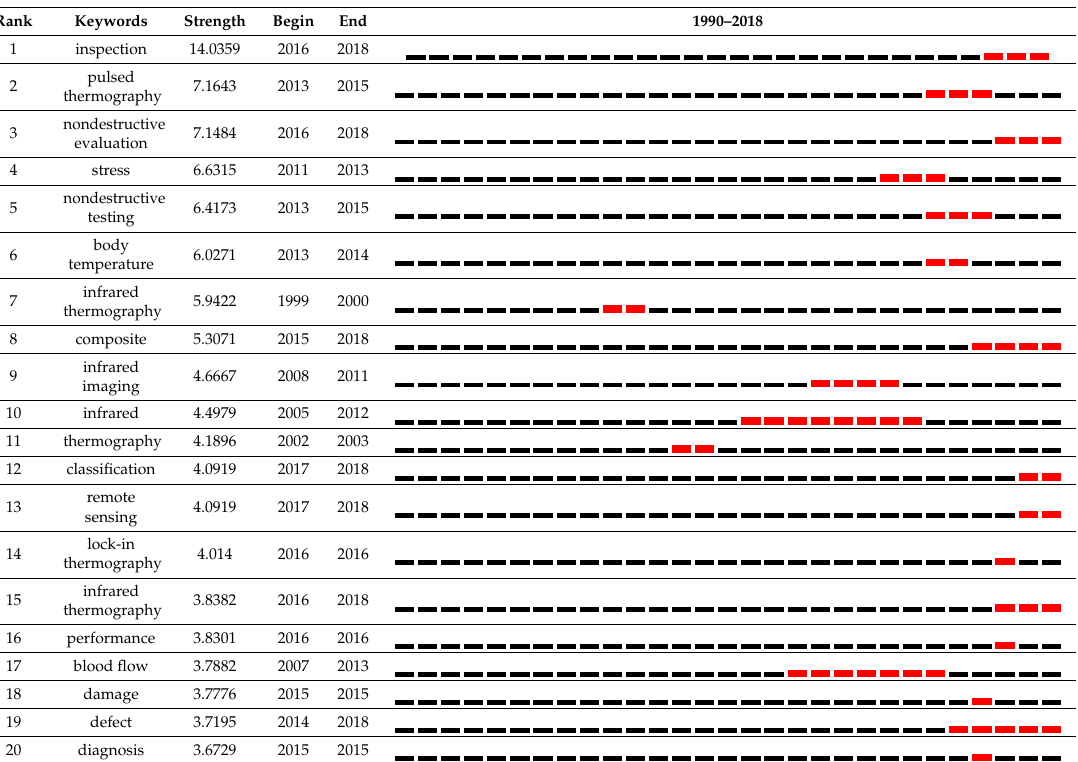
Table 7. Top 20 keywords with the most burst